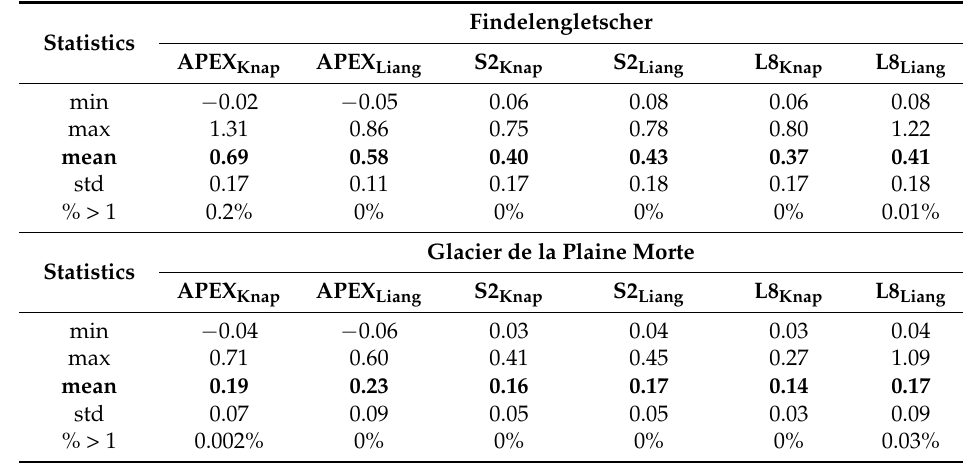
Table 3. Glacier-wide values of albedo products derived from different datasets using the narrow-to-broadband conversion formulae by Knap et al. [29] and Liang [30] for Findelengletscher ( top ) and Glacier de la Plaine Morte ( bottom